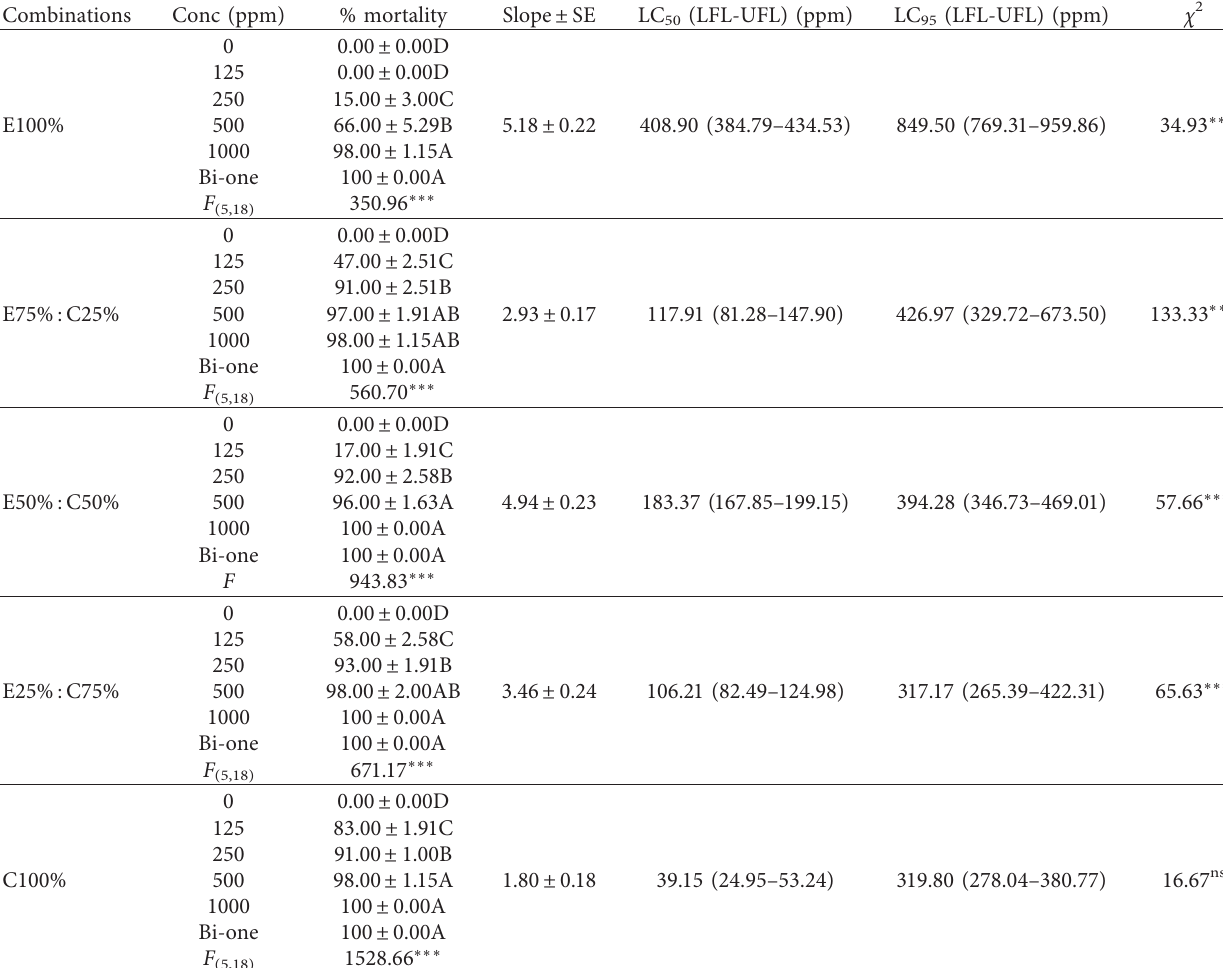
Table 3: Mortality percent of A. gambiae larvae treated with the combination of methanol extracts of E. camaldulensis and C. rigidus and LC 50 as well as LC 95 (ppm) values 24h